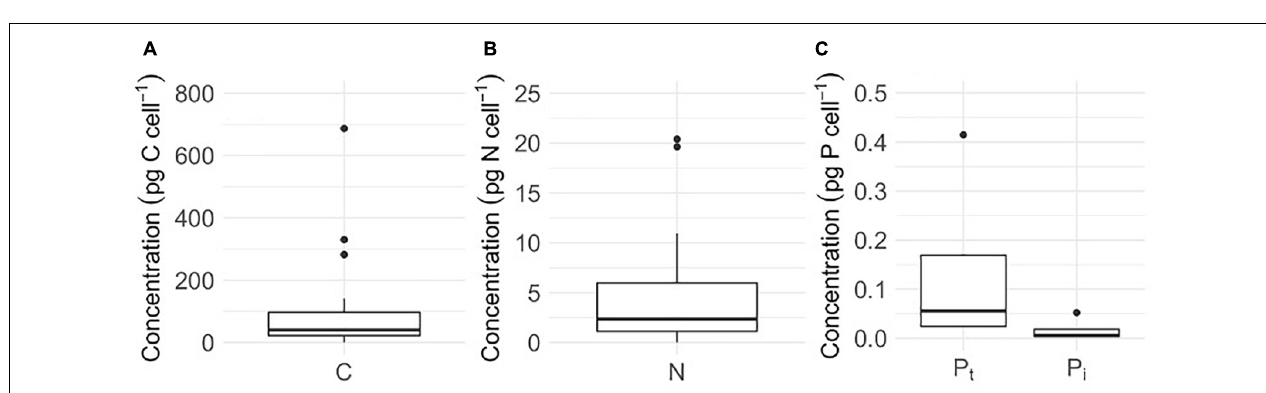
FIGURE 1 | The abundance (A) and cellular biovolume (B) of Ancylonema cf. nordenskiöldii (Ancy., n = 19 abundance, n = 215 biovolume), cf. Mesotaenium berggrenii (Meso., n = 20 abundance and n = 140 biovolume), Cylindrocystis brebissonii (Cylin., n = 2 abundance, n = 5 biovolume), and the total glacier algal assemblage (All, n = 21 abundance n = 360 biovolume) sampled in surface ice from the south western margin of the Greenland Ice Sheet (GrIS) during the mid-2019 ablation season. Plots show median ± interquartile range.